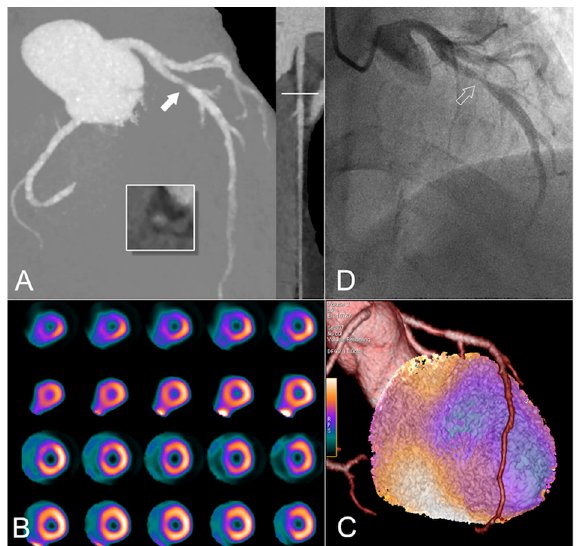
Figure 4. Evaluation of a 49-year old HIV+ male patient with typical angina. The patient had no cardiovascular risk factors and he was referred for exclusion of coronary artery disease with a calculated pre-test probability of 69%. Total cholesterol was 3.6 mmol/L (<5.0), HDL-cholesterol 1.45 mmol/L (>1.0), and LDL-cholesterol 1.8 mmol/L (<3.0). Maximum intensity projection and multiplanar curved reconstruction of the coronary computed tomography angiography (CCTA) datasets ( A ) depict a 70–90% stenosis (white filled arrow) in the proximal left anterior descending artery as shown in the cross-section (inlet). As per clinical routine and in accordance with current guidelines, lesions are primarily graded visually with regard to maximal percent diameter stenosis in our institution. In this particular patient, the qualitative evaluation was complemented by quantitative measurements (using version 2 of CardIQ Xpress/GE Healthcare), because the lesion in the LAD was non-calcified, allowing for more accurate lumen delineation due to the lack of blooming artifacts. The quantitative analysis resulted in a diameter stenosis of 75%. Myocardial perfusion single-photon-computed-emission-tomography (SPECT, B ) confirmed hemodynamical relevance of the lesion, revealing a large perfusion defect during stress (top rows) with reversibility during rest (bottom rows), constituting ischemia in the anteroseptal wall of the left ventricular myocardium. Hybrid CCTA/SPECT imaging ( C ) clearly demonstrates a large area of ischemia in the myocardium subtended by the left anterior descending artery. Finally, obstructive coronary artery disease (white empty arrow) was confirmed during invasive coronary angiography ( D ), and the lesion was treated with a drug-eluting stent.